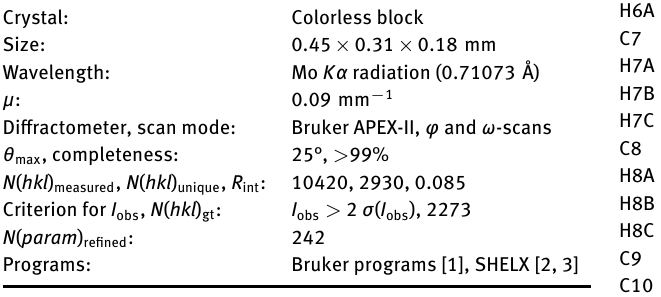
Table 1: Data collection and handling.